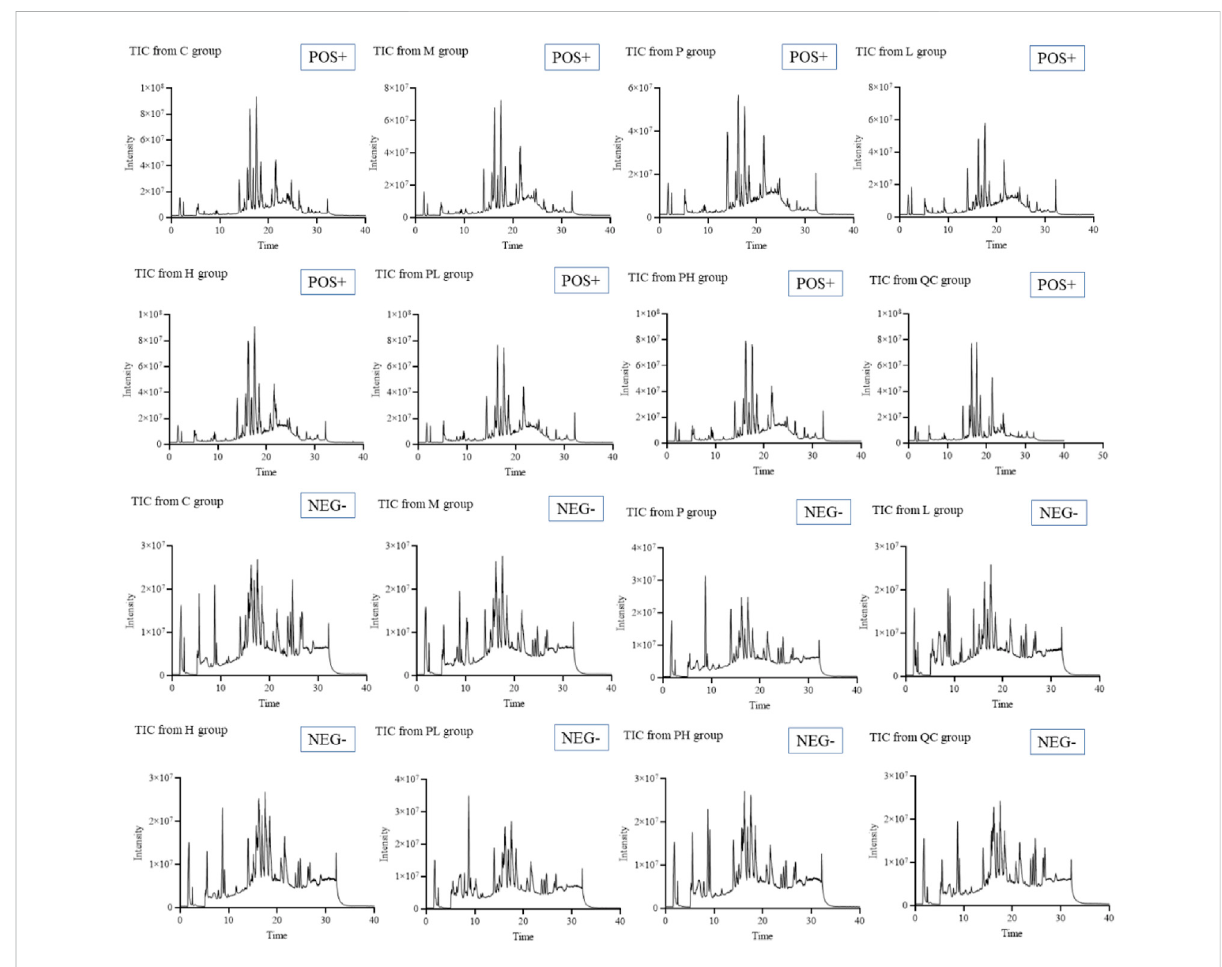
FIGURE 3 Totalionschromatographs(TICs)ofcontrol[C],model[M],cisplatin[P],GYPlow-dose[L],GYPhigh-dose[H],cisplatin+low-doseGYP[PL]and cisplatin + high-dose GYP [pH] in the positive model (POS +) and negative model (NEG -).